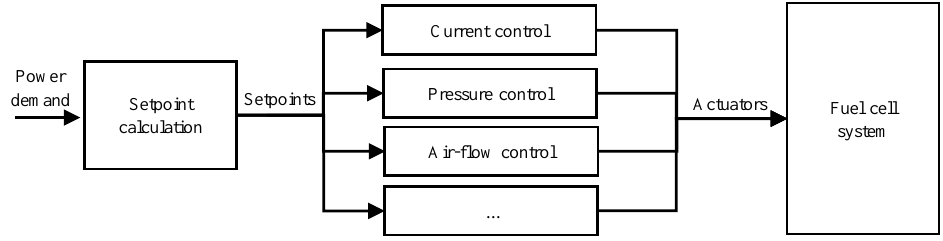
Figure 3. Control scheme of the fuel cell